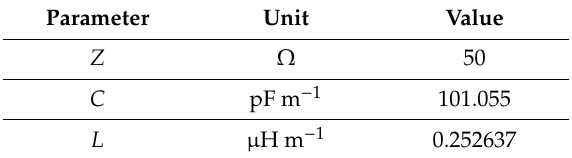
Table 3. Parameters of the RG– 213U MIL.C 17 / D cable of the lc line (Figure 3) [29].